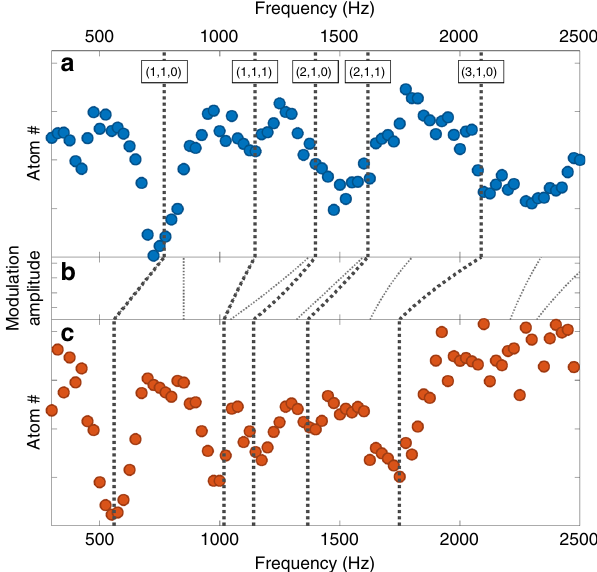
Fig. 3 Tunable excitation spectra via trap shaping. a Bound fraction after a 1-s pulse as a function of excitation frequency for an unmodi fi ed trap. Bold dotted lines are theoretically predicted frequencies of collective resonances expected to couple to our drive. Labels on theory lines indicate the quantum numbers ( k , β , γ ), using the notation of 26 . β and γ are parity quantum numbers, and k indicates the form of the nodal surface for the excitation. The quantum number m is 1 for all resonances plotted. The only inputs to this theory are the three trap frequencies. The resonance at half the fundamental frequency is believed to be due to parametric excitation of a dipole oscillation in the direction of gravity. Pulse amplitudes were increased from 0.6 μ m at low frequency to 3 μ m at the highest frequency to maximize peak visibility. b Evolution of predicted resonances under continuously increasing trap broadening. Thinner dotted lines represent resonances which are not dipole-allowed for this drive polarization. c Bound fraction after a 1-s pulse as a function of excitation frequency for a trap broadened in one direction as described in the Methods